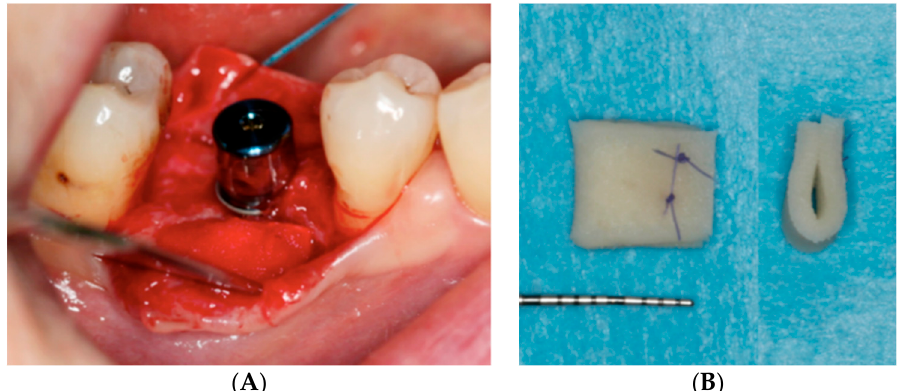
Figure 1. ( A ) Intra-operative view: the porcine-derived collagen matrix (PDCM) (Mucoderm ® , Botiss gmbh, Berlin, Germany) was trimmed to the desired shape and size and then positioned under the elevated buccal flap. ( B ) In case of advanced horizontal defects, the PDCM was folded in half and secured with resorbable sutures.